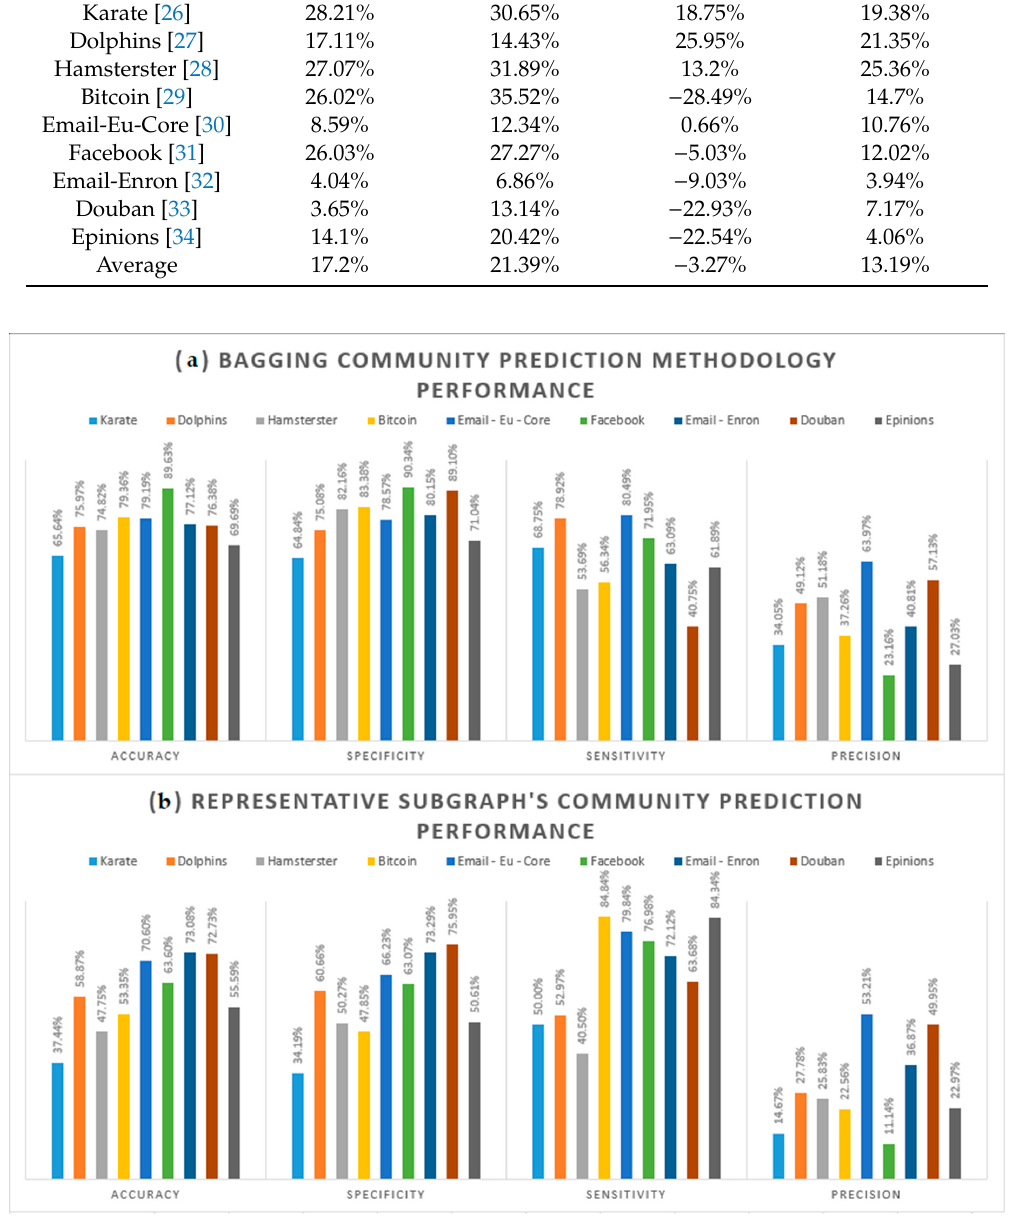
Figure 2. Prediction performance per community prediction methodologies. ( a ) Bagging community prediction methodology’s prediction performance; ( b ) Representative subgraph’s community prediction methodology’s [4] prediction performance.